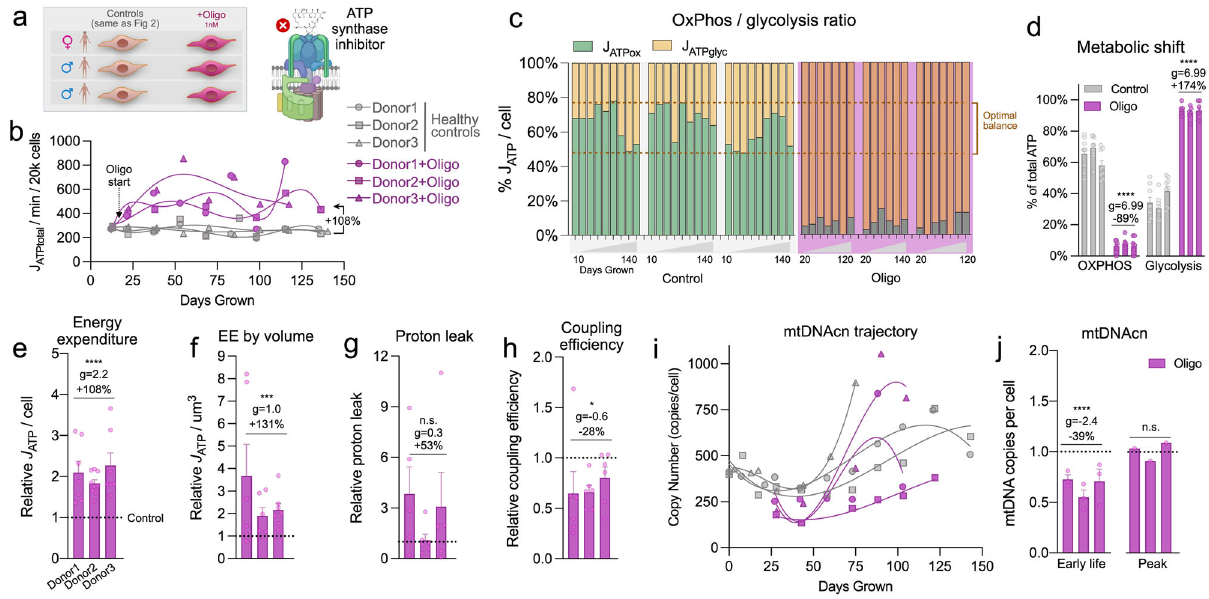
Fig. 3 Pharmacological inhibition of the mitochondrial F 0 F 1 ATP synthase triggers hypermetabolism. a Schematic of the study design for fi broblast pro fi ling across the lifespan from three Control donors treated with 1 nM Oligomycin (Oligo). b Lifespan trajectories of J ATP (Glycolytic + OxPhos) derived from oxygen consumption rate (OCR) and extracellular acidi fi cation rate (ECAR) obtained from Seahorse measurements across the cells ’ lifespan (up to 150 days). Percentages show the total average difference between Oligo and Control. c Balance of J ATP derived from OxPhos and glycolysis across the lifespan and d oligo-induced metabolic shift. Dotted lines denote the range in control cells. e Relative average lifespan energy expenditure by cell line normalized to control, f corrected for cell volume. g Average of proton leak and h coupling ef fi ciency measures on the Seahorse normalized to control. i Lifespan trajectories and j average mtDNA copy number at the fi rst three time points (early life) and peak value across the lifespan. n = 3 individuals per group, 7 – 9 timepoints per individual. Data are means ± SEM. * P < 0.05, ** P < 0.01, *** P < 0.001, **** P < 0.0001, mixed effects model for Oligo vs.